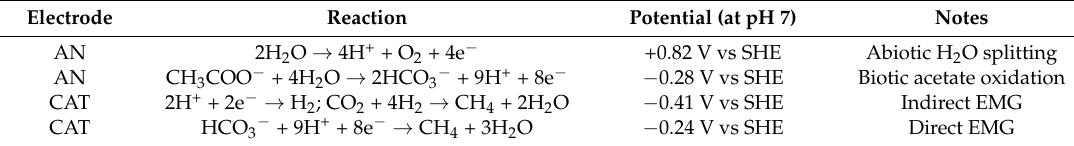
Table 1. Anode and cathode reactions of EMG-BES systems (SHE = standard hydrogen electrode).